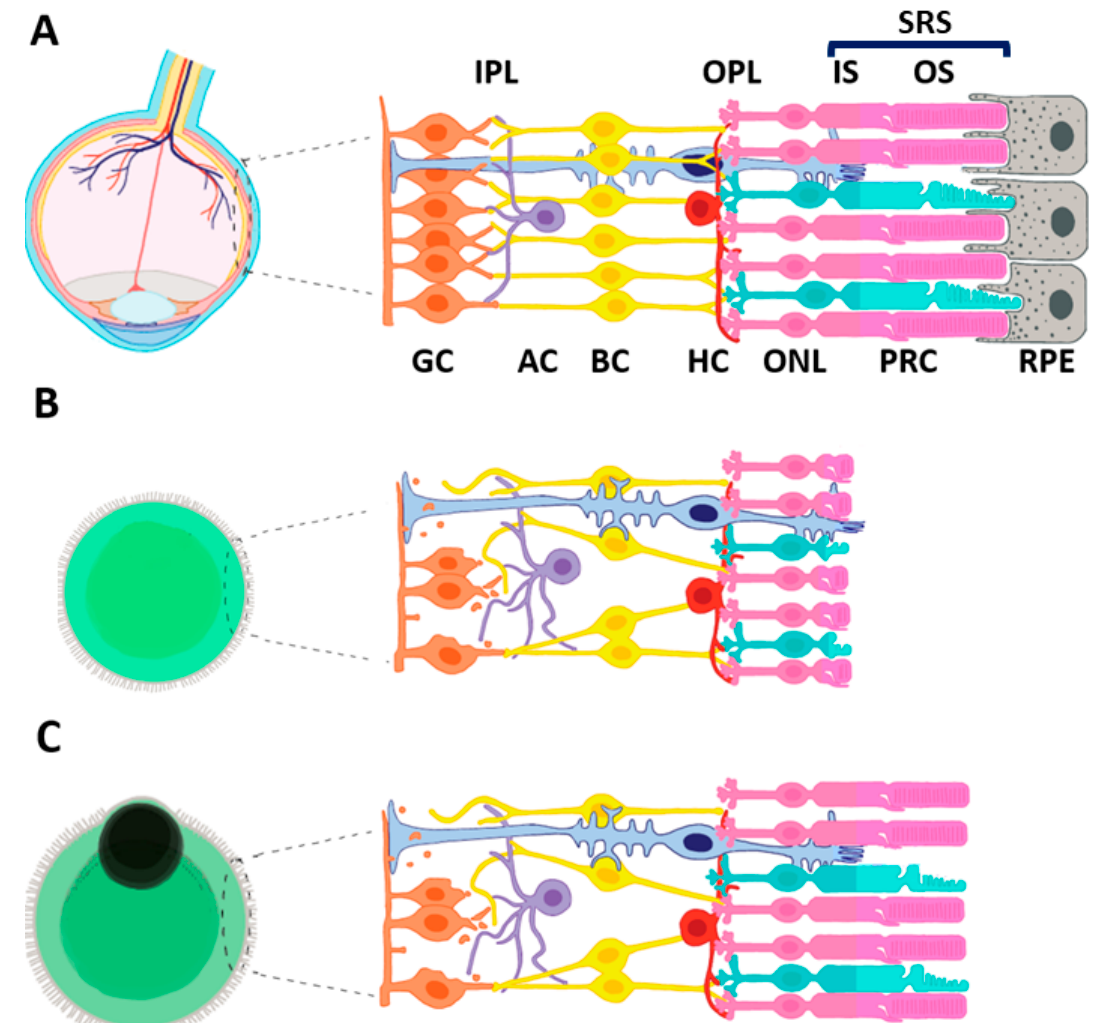
Figure 2. ( A ) In vivo cellular organization of the mature retina. The interactions occurring between distinct cell types and between photoreceptors and RPE are shown. See Figure 1A legend. ( B ) ROs lacking RPE display photoreceptors with severely reduced OS and progressive loss of RGCs and interneurons. ( C ) ROs with a patch of RPE localized on one side develop photoreceptors with distinct OSs, although shorter than those observed in the retina. Progressive loss of RGCs and interneurons is also observed.